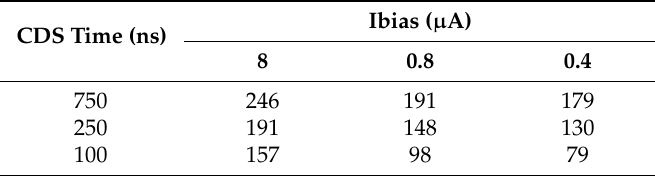
Table 3. Expected average SF read noise ( µ V rms ) as a function of t CDS (ns) and SF Ibias ( µ